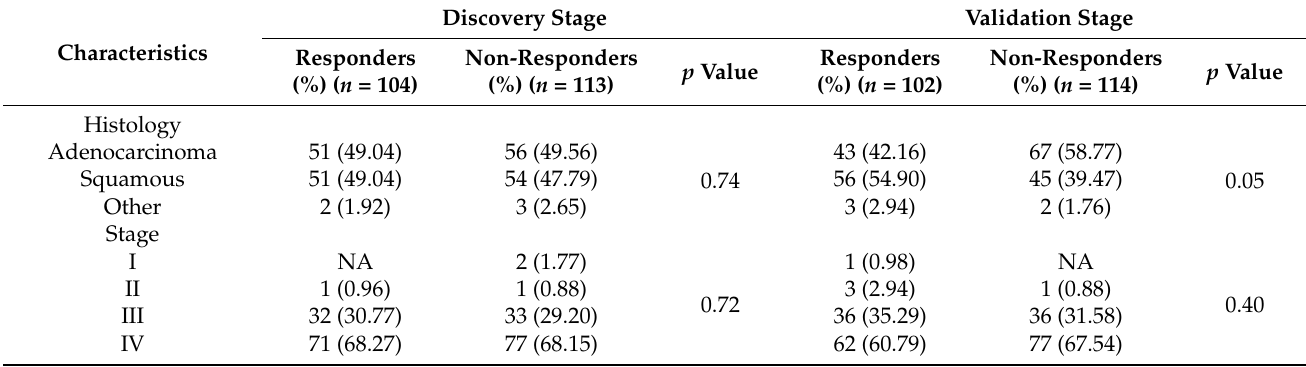
Table 1. Characteristics of NSCLC patients for the two